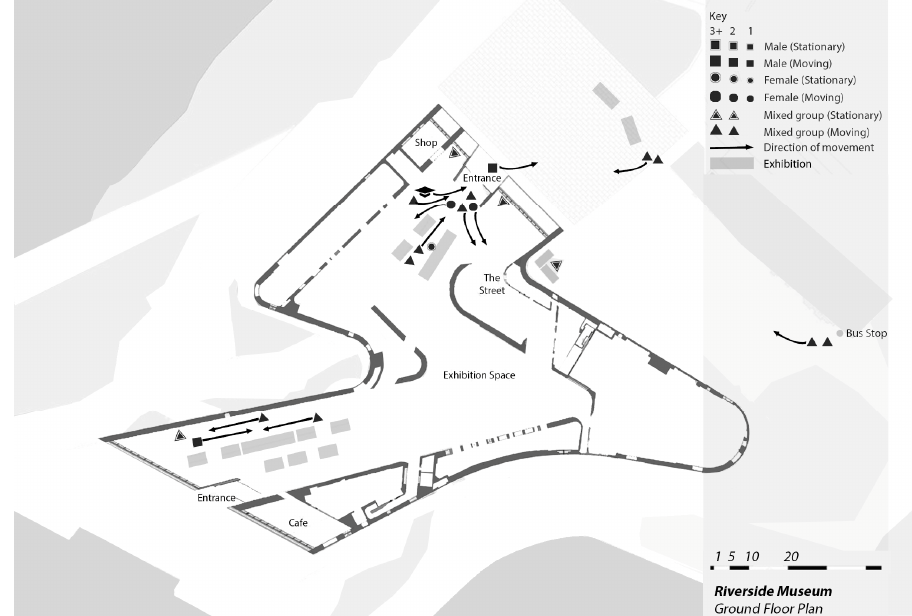
Figure 10. A representative navigational map, on midday Mondays/Wednesdays at the Riverside Museum. (Floorplan by L. MacLean based on plan by ZHA published in ArchDaily, annotations by A. Salama and L. MacLean)